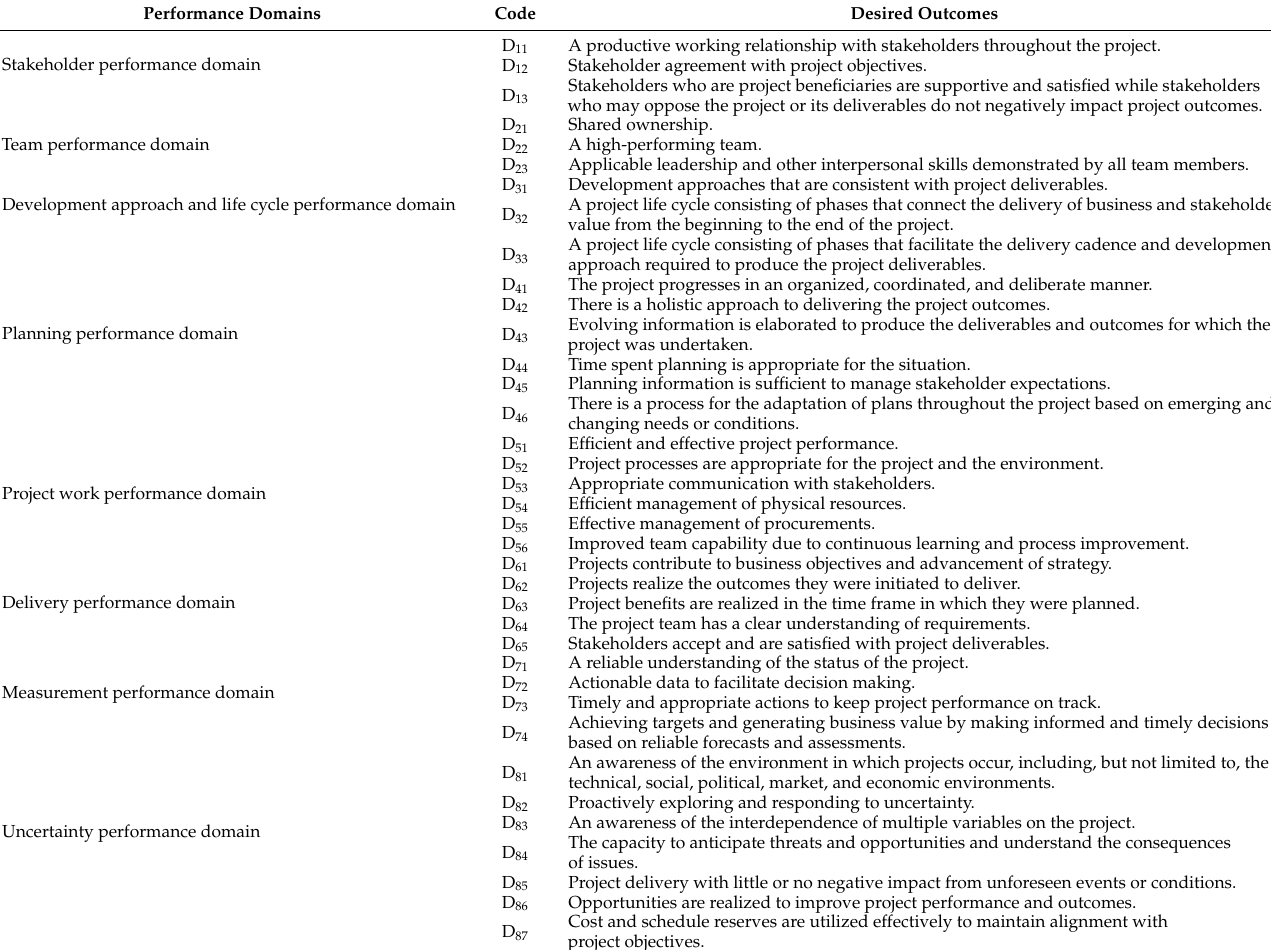
Table 2. Assessment index system of